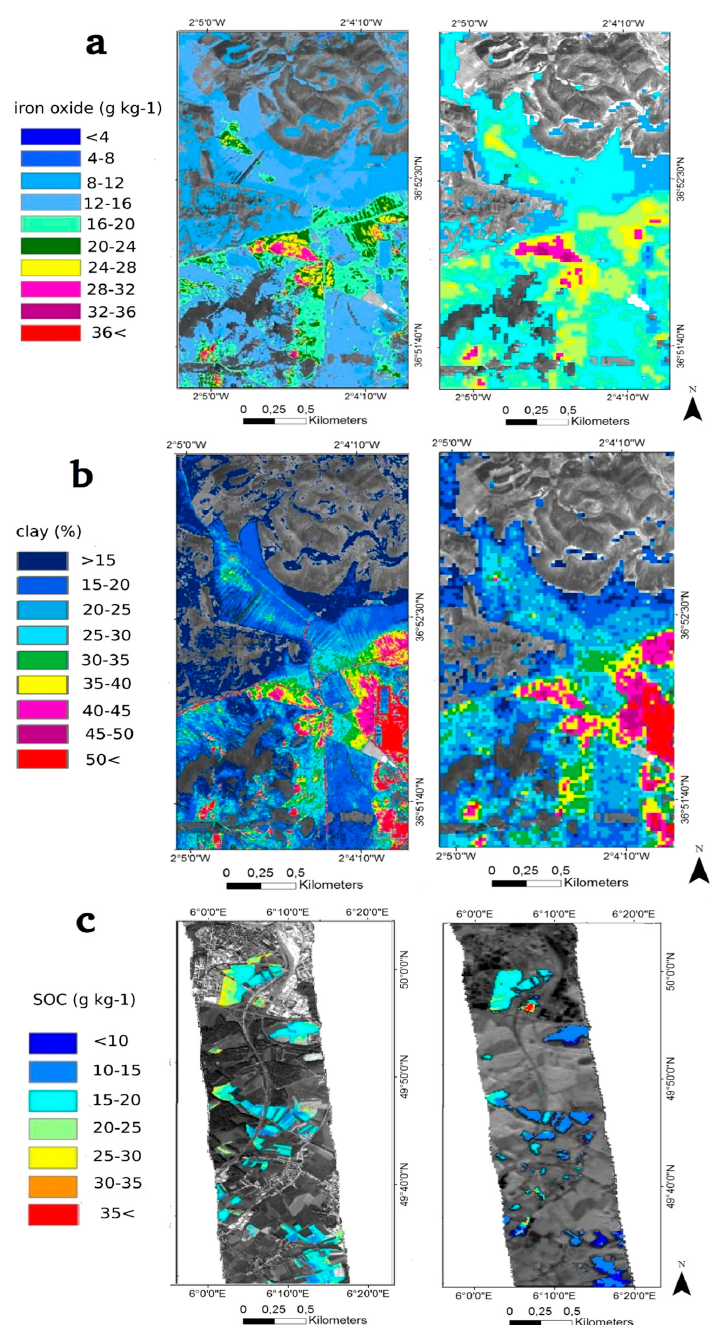
Figure 6. Maps of predicted soil properties: ( a ) Iron oxide, Cabo de Gata test site; ( b ) Clay content, Cabo de Gata test site; and ( c ) SOC content, Luxembourg test site. Left : Airborne imagery ( a , b ) HyMAP (4.5 m); and ( c ) AHS (2.6 m). Right : Spaceborne simulated EnMAP images (30 m).